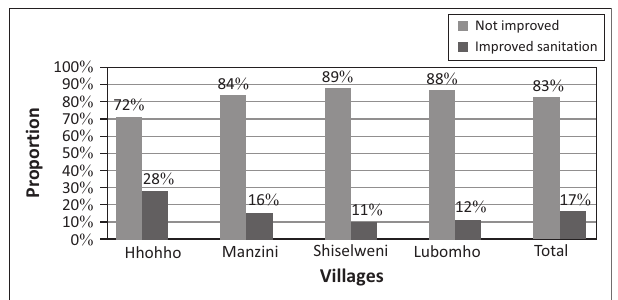
Mbabane FIGURE 2: Proportion of household with improved